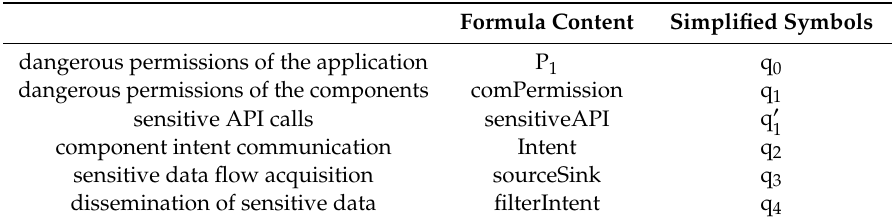
Table 3. Symbol simplification of Equation (9).